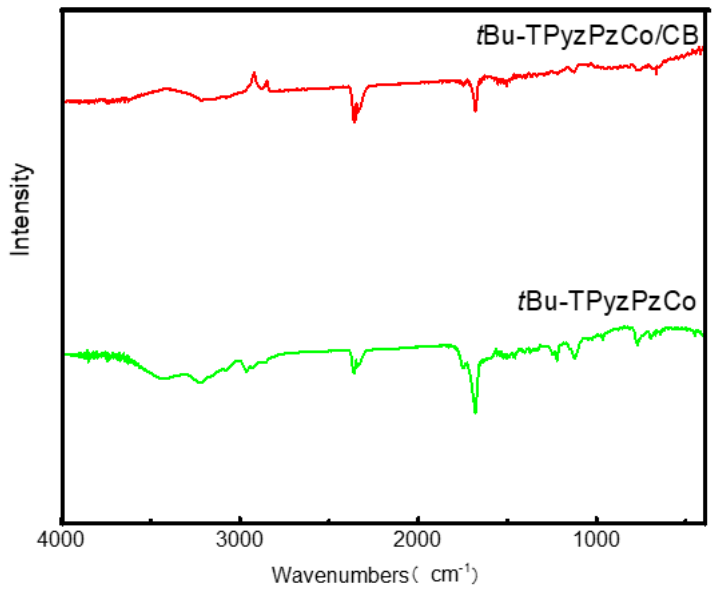
Figure 2. FTIR spectroscopy results of t Bu-TPyzPzCo before and after loading.